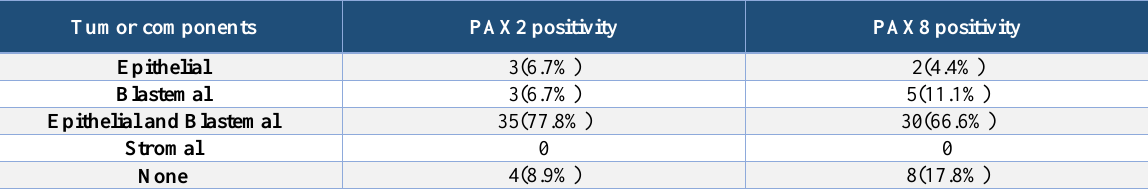
Table 1 .PAX2 and PAX8 expression in different components of Wilms